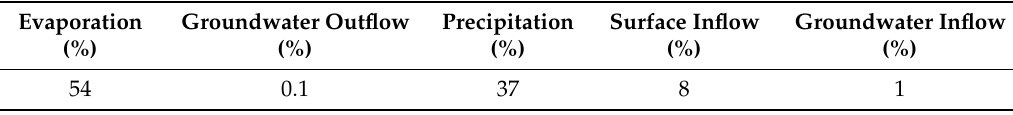
Figure 14. Annual water balance of Lake Linlithgow (1965–2006). Thus, Lake Linlithgow is a groundwater through ‐ flow lake, and the lake–groundwater interaction is important since it affects the environmental health of this major wetland. 4.2. Water Budget Errors and Sensitivity Analysis A sensitivity analysis shows that the model is most sensitive to evaporation and precipitation (Figure 15), and surface inflow to a lesser extent. However, the most likely source of error within the model is estimating the ungauged surface inflow (i.e., Boonawah Creek) by the tanh relationship from Grange Burn; this could be in error if the threshold value at which cumulative surplus rainfall becomes runoff in Grange Burn at Morgiana is different to that of the smaller catchment of Boonawah Creek.